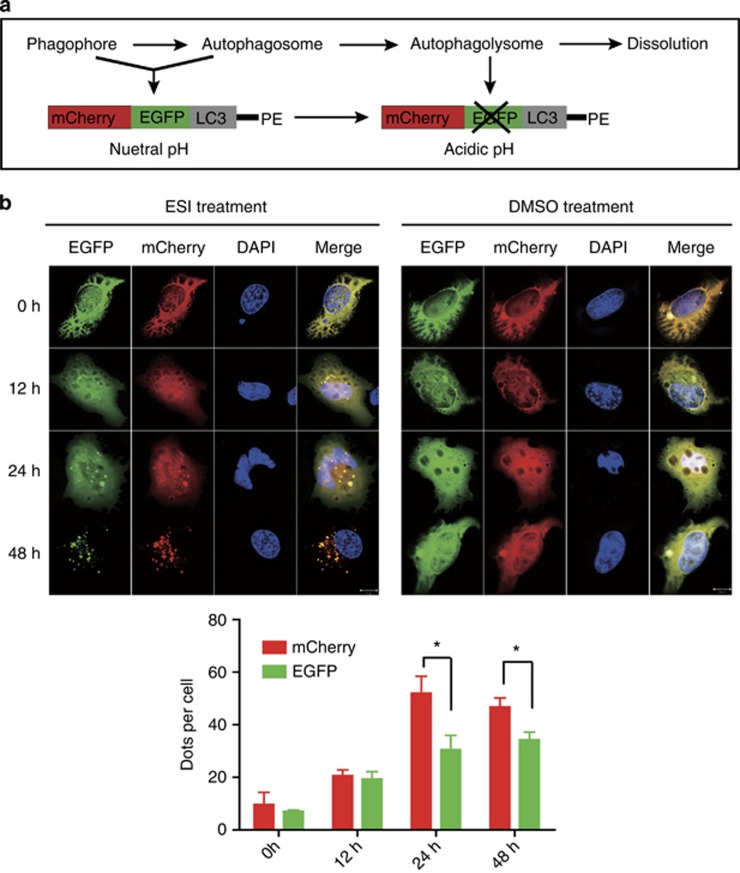
ESI induces the appearance of autophagy flux in lung cancer cells. (a) Schematic representation of mCherry-EGFP-LC3 constructs. (b) H1299 cells overexpressing mCherry-EGFP-LC3 were treated with 1.6 μM ESI (left) or DMSO (right) for 0, 12, 24, 48 h, respectively, and then subjected to confocal microscopy. Scale bar: 10 μm. The average numbers of green and red LC3 dots per cell in each condition were quantified, and >30 cells were counted in each condition. All data were representative of three independent experiments. Bars, S.E.M.; *P<0.05